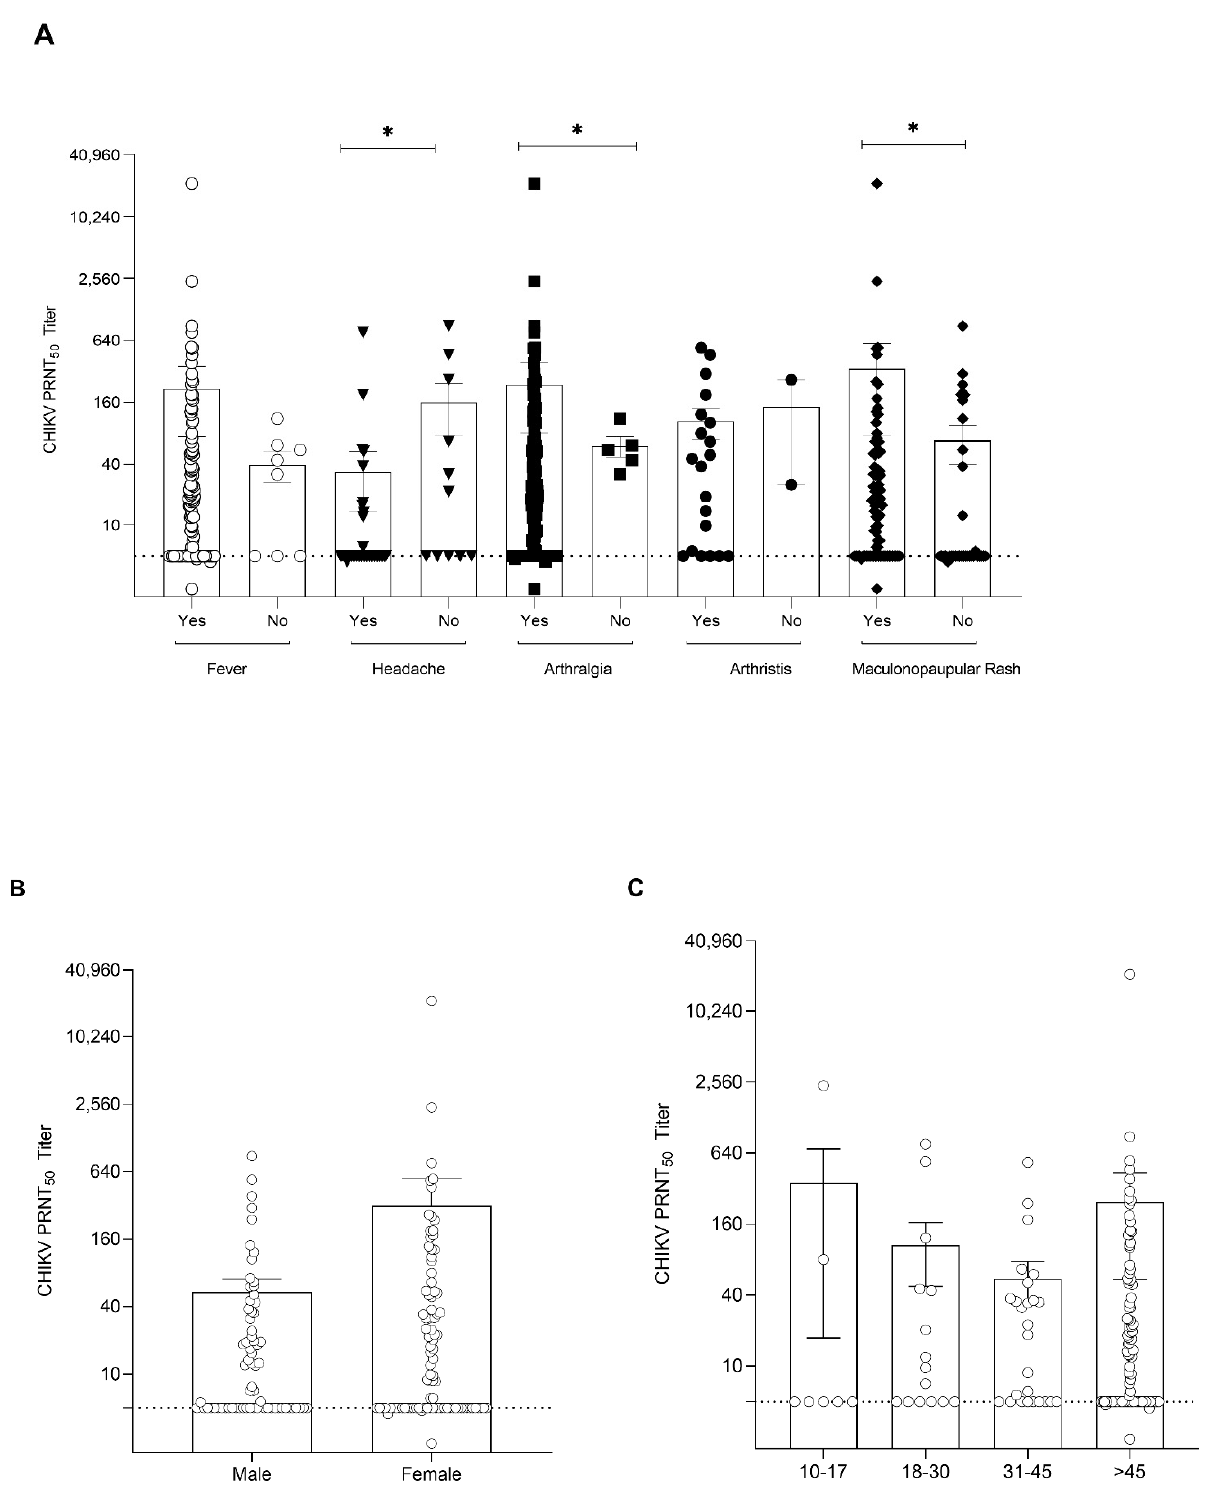
Figure 3. Association of CHIKV neutralizing antibodies vs. clinical features ( A ), gender ( B ), and age groups ( C ). Error bars showing the standard deviation of the sample means. p -values were calculated using the Mann − Whitney test. * p < 0.01.